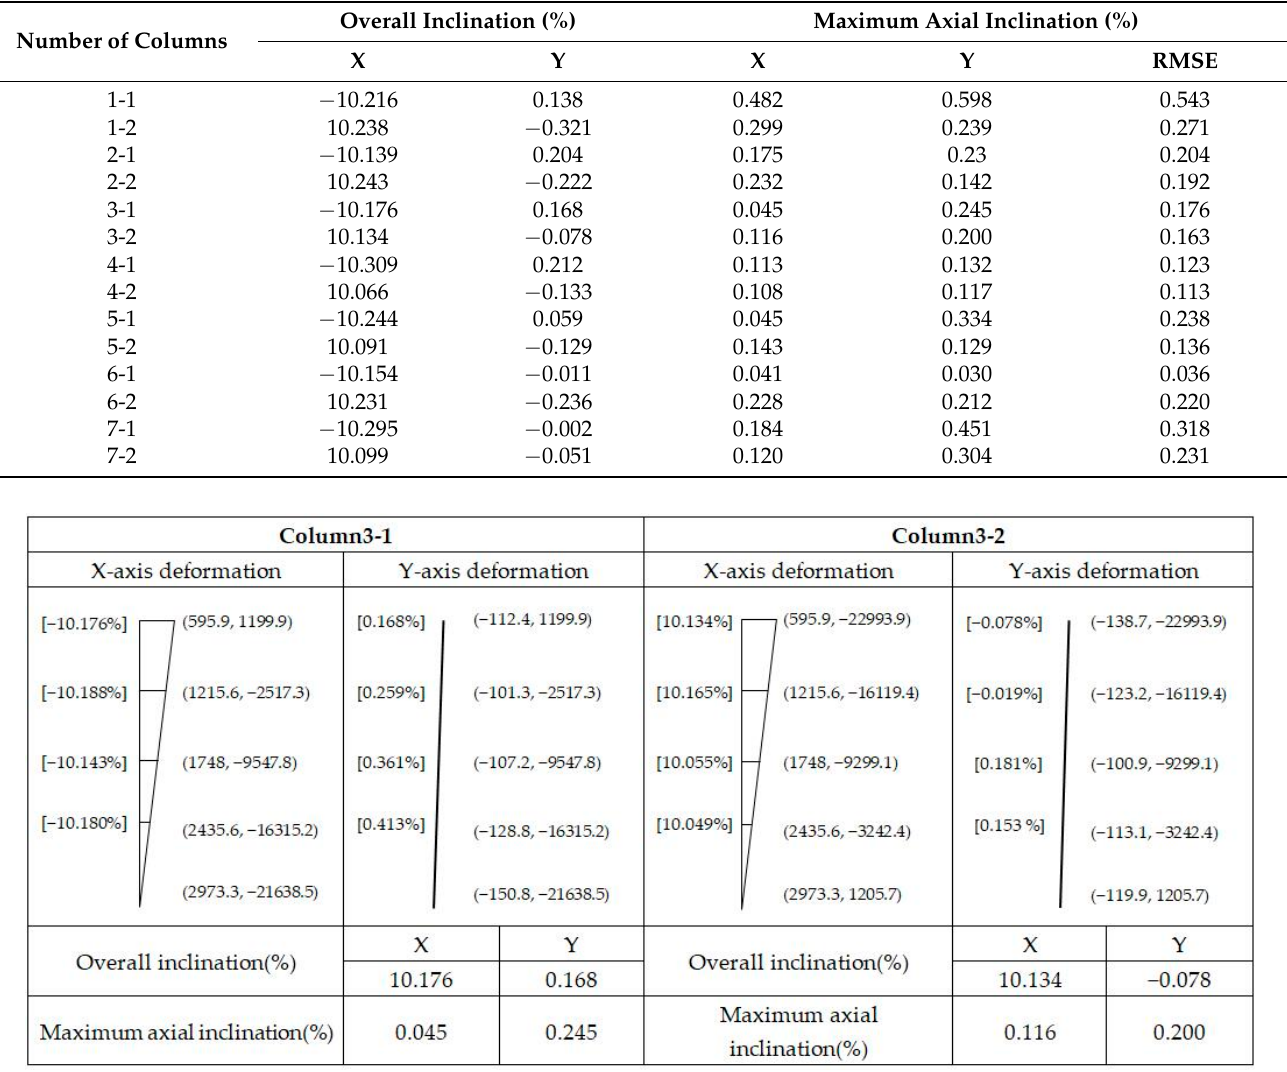
Figure 9. Inclinations in different directions. Table 3. Inclination of each column by the proposed method.